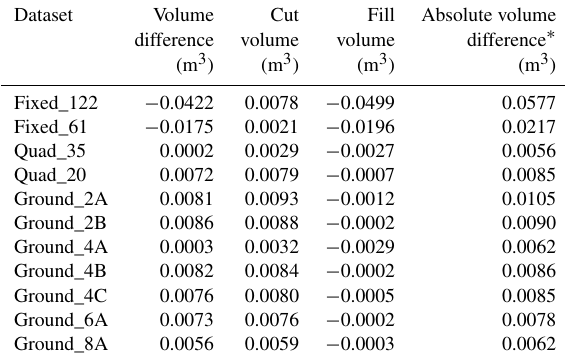
Table 6. Volume difference between photogrammetry and ter- restrial lidar raster grids generated from three-dimensional point